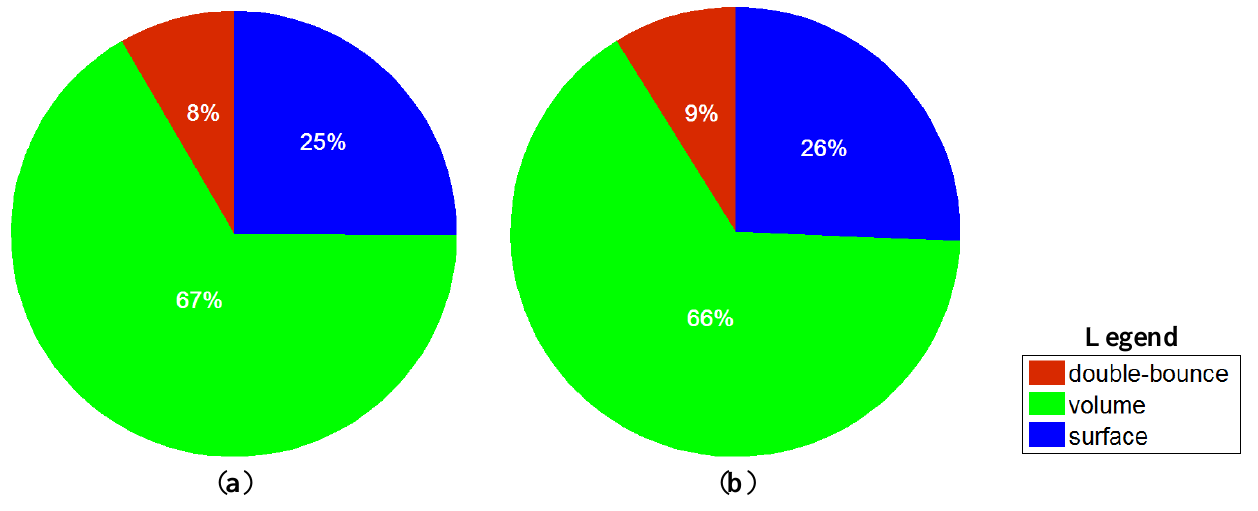
Figure 3. ( a ) Power distribution of original Freeman-Durden decomposition in vegetated area; ( b ) Power distribution of proposed adaptive decomposition in vegetated